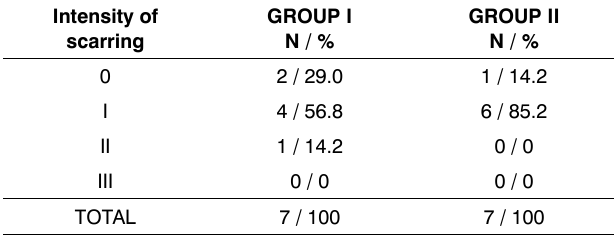
Table 3. Comparative analysis of the intensity of scarring in the grafted vocal fold in groups I and